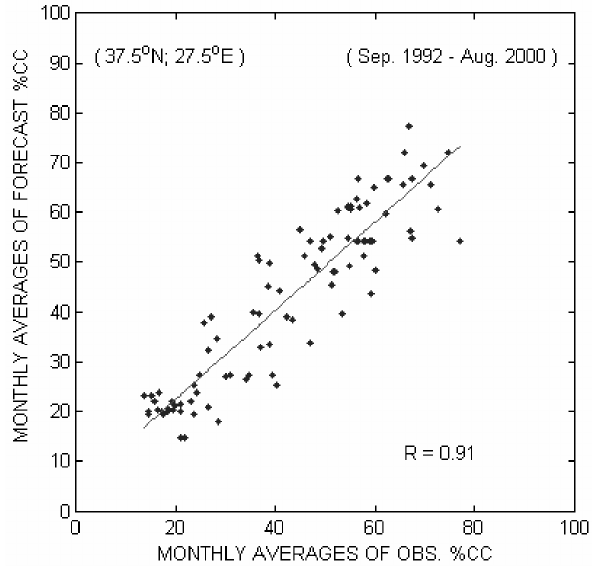
Fig. 10. The scatter diagram of the one-month in advance forecast %CC values versus the observed %CC values and the best-fit line. R is the cross correlation coefficient between the forecast and the observed values.